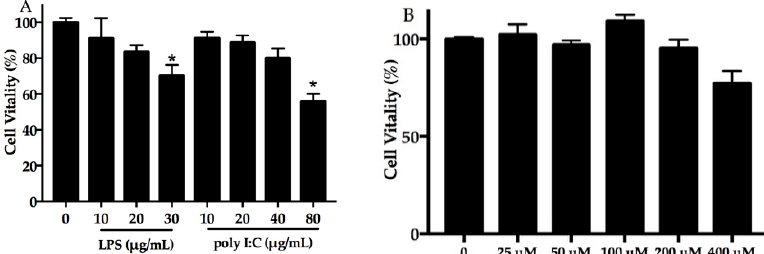
Figure 1. E ff ect of poly I:C, LPS, and docosahexaenoic acid (DHA) on cell viability. Normal human epidermal keratinocyte (NHEK) cells exposed to poly I:C (0–80 µ g / mL) and LPS (0–30 µ g / mL) ( A